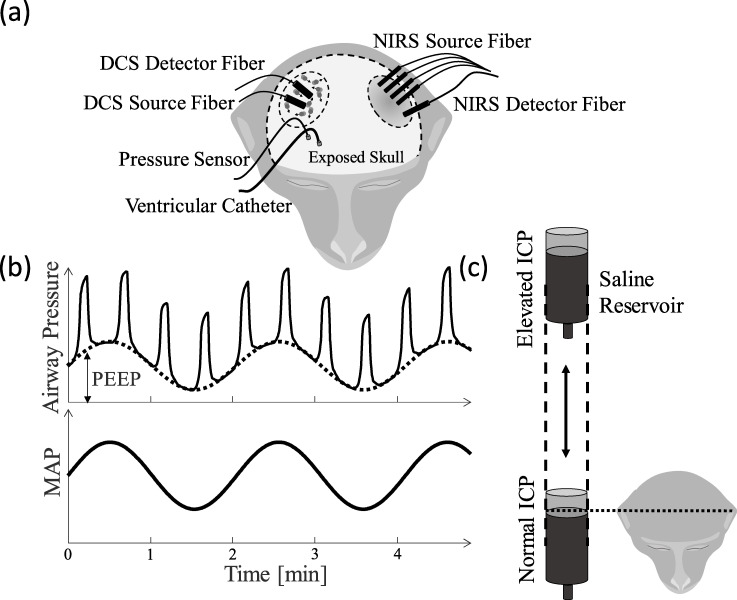
Experimental setup.(a) Location of DCS, catheter and ICP sensor relative to the NHP’s head. These positions were maintained across all NHPs. (b) The saline reservoir connected to the ventricle catheter was raised and lowered in a circular motion on a lever, whose center point was placed relative to the NHP’s head to allow for ICP manipulation. (c) Change in positive end-expiratory pressure (PEEP), the pressure remaining in the lungs after exhalation, through active programming of the ventilator influences systemic mean ABP (MAP).